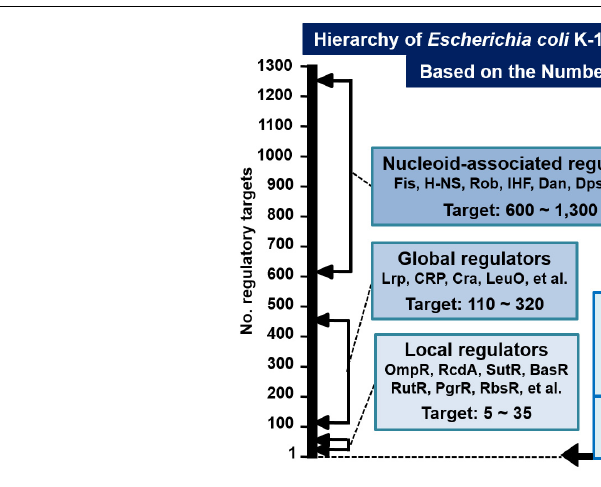
TABLE 1 | List of single-target TFs.